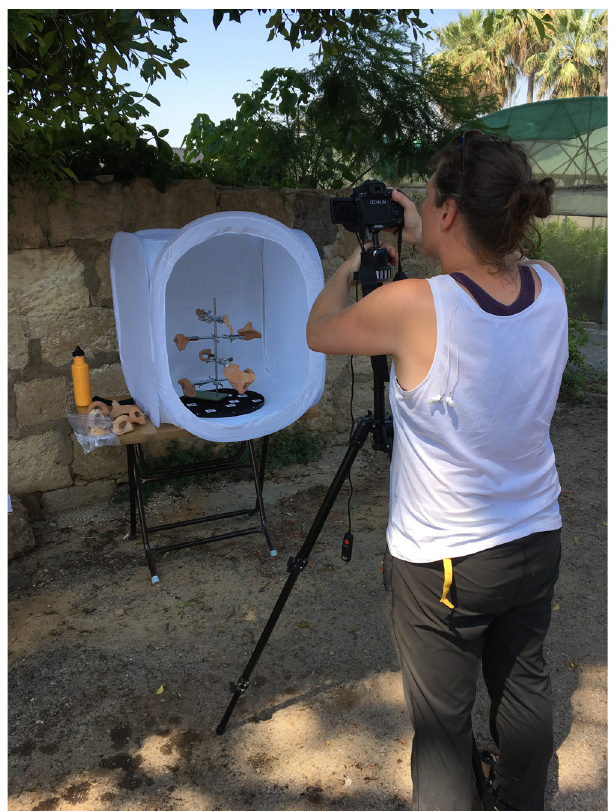
Figure 8: Recording scenario with light tent and “ pottery tree ” ( background color was later changed to black )